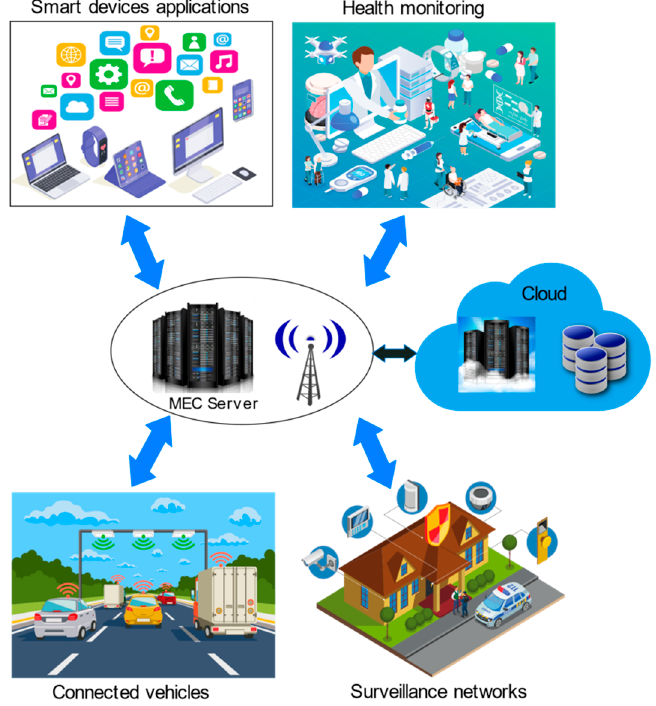
Figure 5. Multi-access edge computing systems—a general architecture.